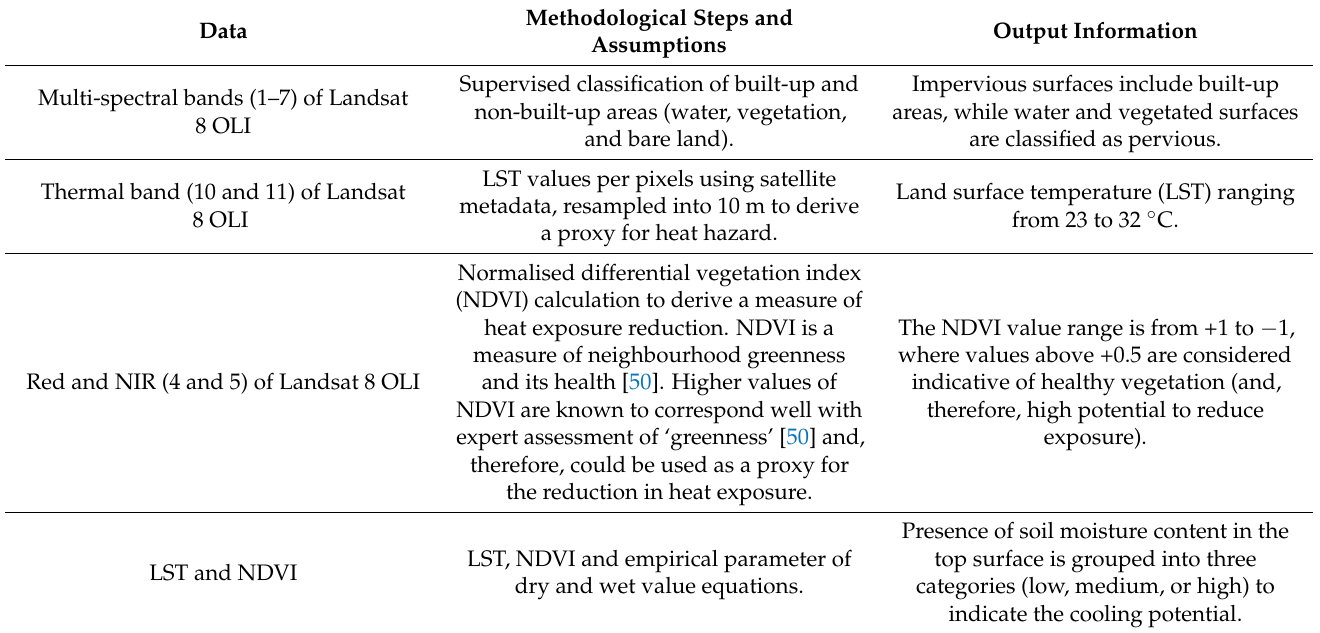
Table 3. Data processing approach—physical environment and climate